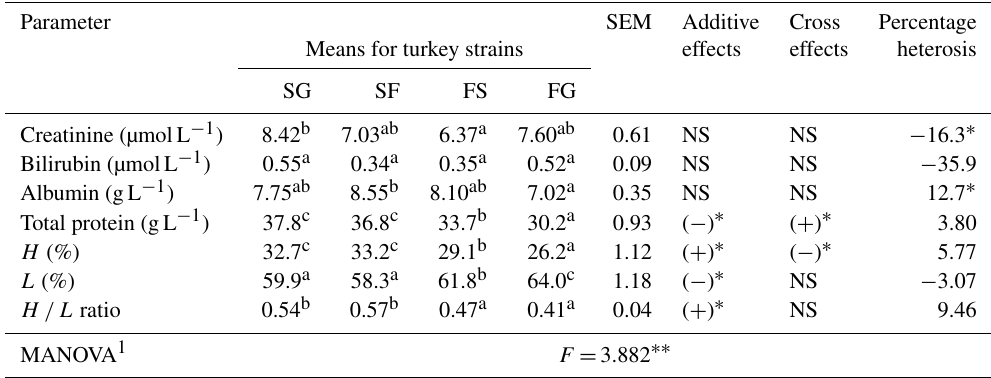
Table 1. Means, standard error of the mean (SEM) and orthogonal contrasts on biochemical and hematological values in serum of female turkeys from different genetic groups. Parameter SEM Additive Cross Percentage Means for turkey strains effects